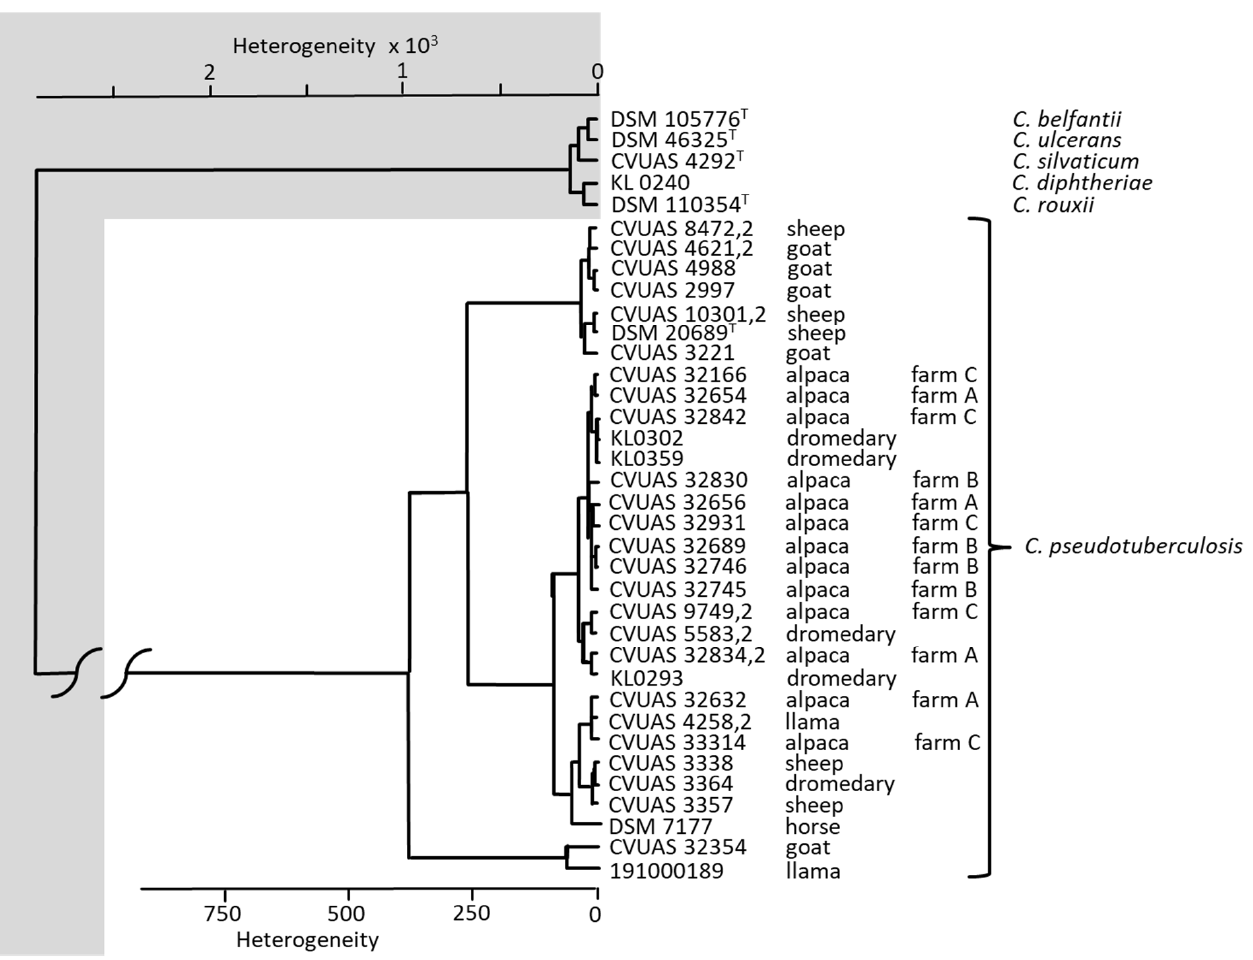
Figure 4. Dendrogram of IR-spectra of Corynebacterium (C.) pseudotuberculosis isolates from alpacas in comparison with spectra from dromedaries, llamas, goats and sheep. Isolates of C. ulcerans , C. silvaticum , C. rouxii , C. diphtheriae and C. belfantii were included for differentiation of the corynebac- terial species belonging to the C. diphtheriae group. Table 3. Determination of minimal inhibitory concentration (MIC) values (mg/L) for C. pseudotuber- culosis isolates using the broth microdilution method carried out in microtiter plates. Evaluation of